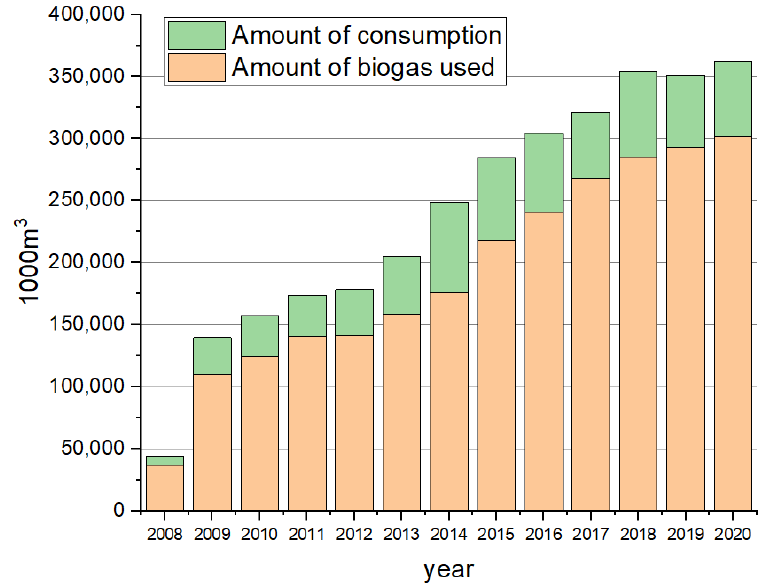
Figure 2. Biogas generation from digestion facilities in South Korea.